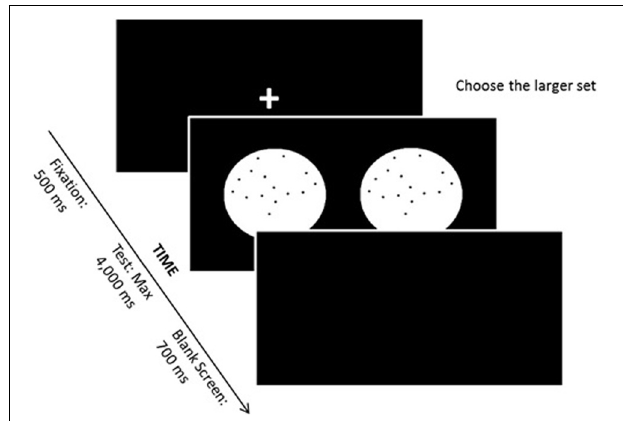
FIGURE 1 | Nonsymbolic magnitude comparison task.